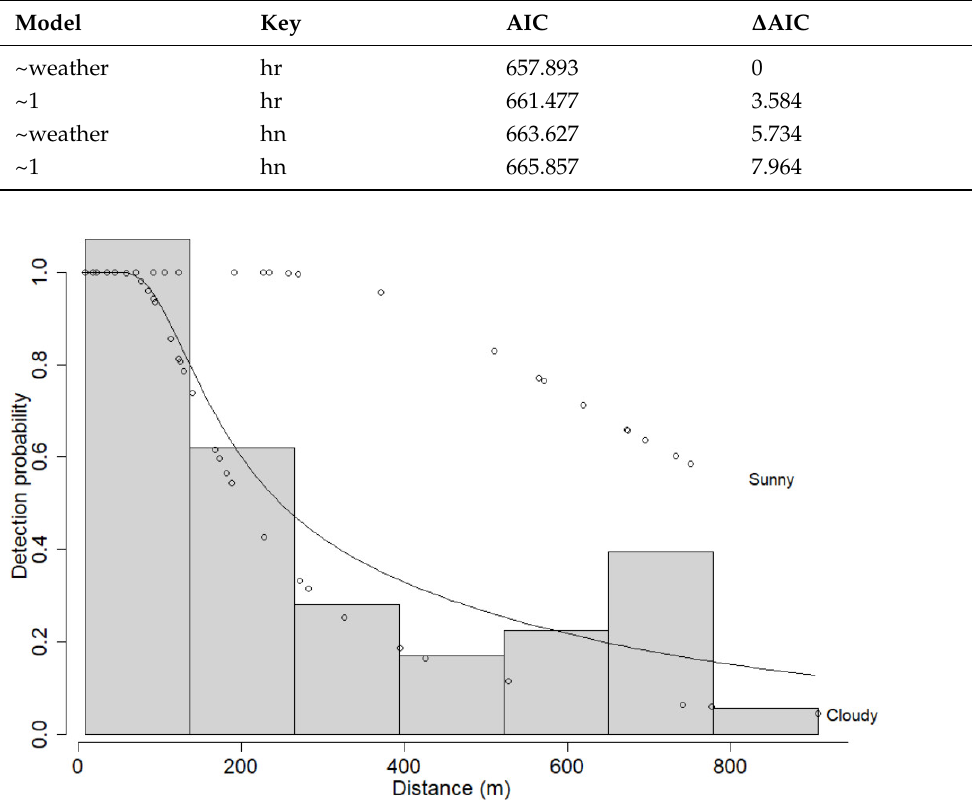
Figure A2. Detection probability function based on the line transect distance sampling of Svalbard reindeer. The best model was fitted at a continuous scale for observed distances and included a hazard rate key detection function with weather (sunny or cloudy) as covariate. Observations of reindeer clusters are illustrated by dots along the curve. Table A3. Density model obtained from ground distance sampling. We used the most parsimonious density model from Le Moullec et al. [22], which modelled individuals per segment as a function of NDVI using a log-link quasi-Poisson model. This model was fitted using the restricted maximum likelihood (REML) framework.